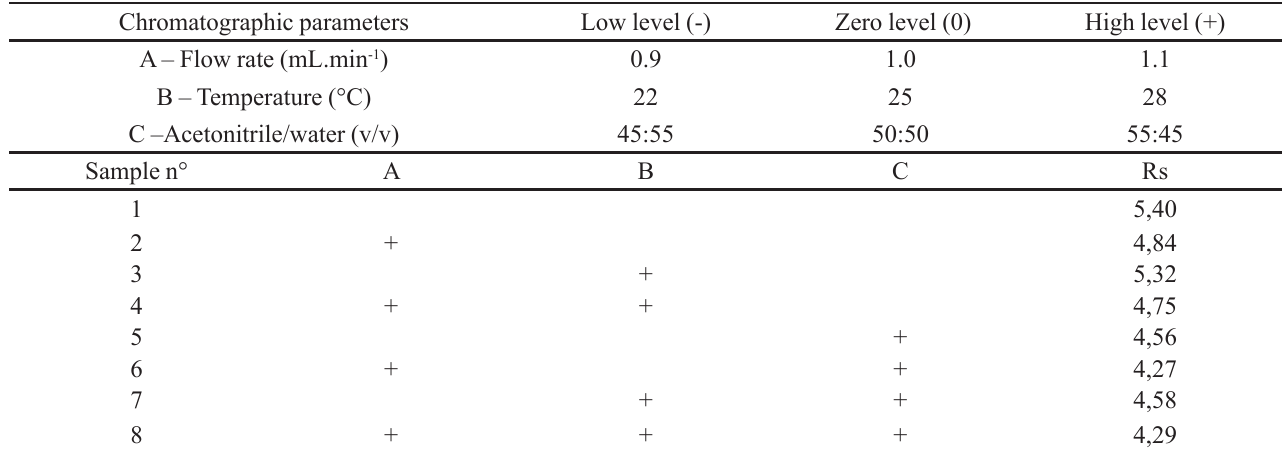
TABLE VI - Chromatographic parameters used for robustness determination Chromatographic